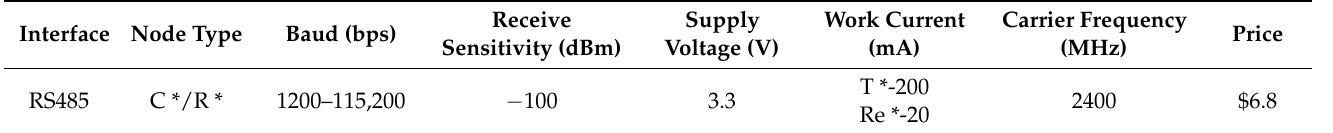
Table 1. Basic parameters of ZigBee